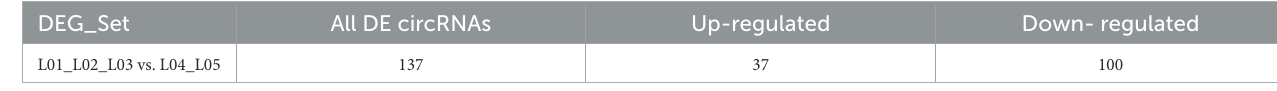
TABLE 7 Statistics of the number of DE circRNAs.